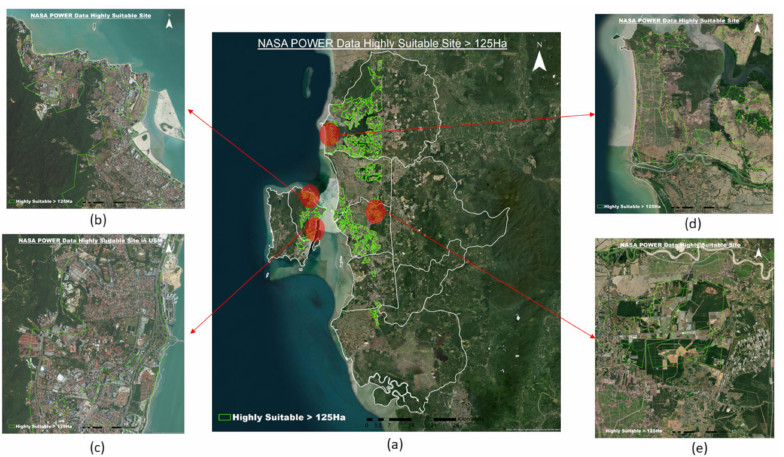
Figure 10. ( a ) Highly suitable sites with a size greater than 125 Ha, ( b ) suitable parcel 1, built-up area, ( c ) suitable parcel 2, built-up area, ( d ) suitable parcel 3, agricultural land, ( e ) suitable parcel 4, agricultural land.